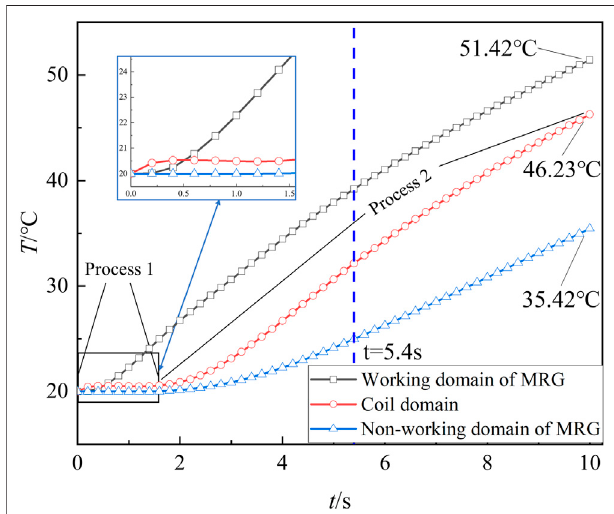
FIGURE 10 | Temperature rise curve of each domain in working condition Ⅰ